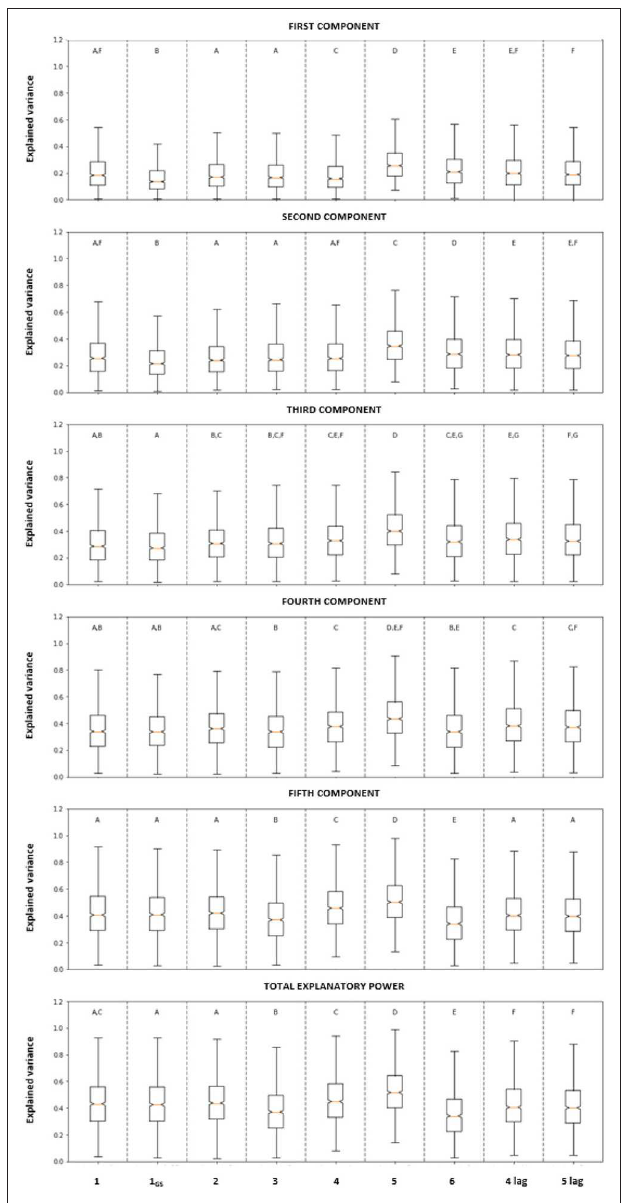
FIGURE 2 | Fraction of cumulated variance of NDVI GS explained by the components 1 to 5 (rows 1–5) and total explanatory power (bottom panel) of the combination of the climatic variables considered in each PLS analysis (details in Table 2 ). For the analyses involving just 5 climatic variables, the content of the last two panels is the same. The boxes extend from the first and the third quartile, the end of the whiskers are computed as 1.5*IQR (Interquantile Range). The median values are indicated by the orange line. The notches extend over the 95% confidence intervals of the median, as determined by bootstrapping. Bars with the same letter are not significantly different at p = 5% (as determined by the Kruskal-Wallis and Dunn